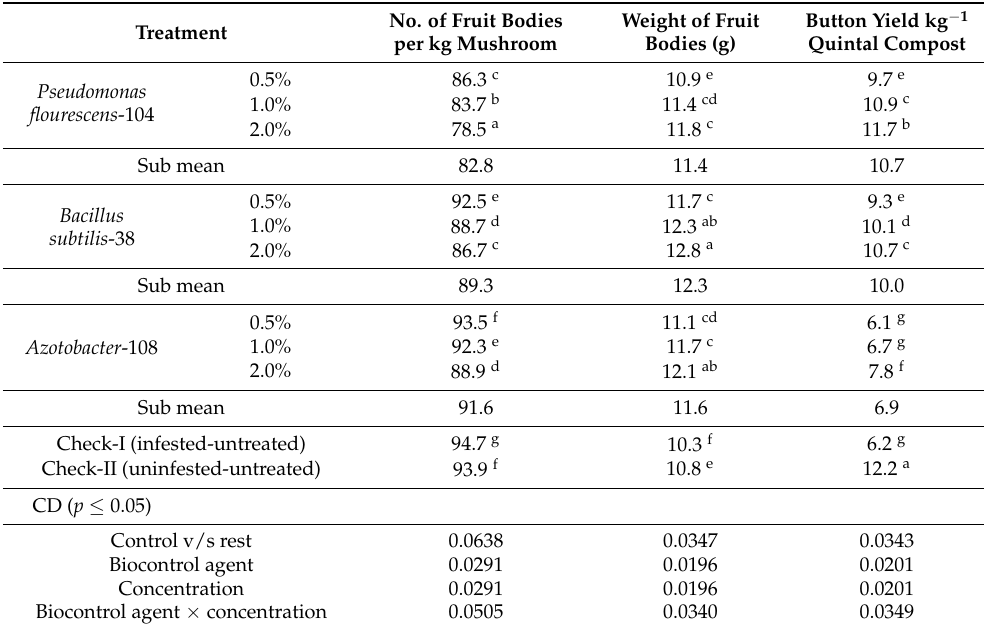
Table 8. In vivo effect of bacterial antagonists on yield and yield components of button mushrooms at concentrations between 0.5 and